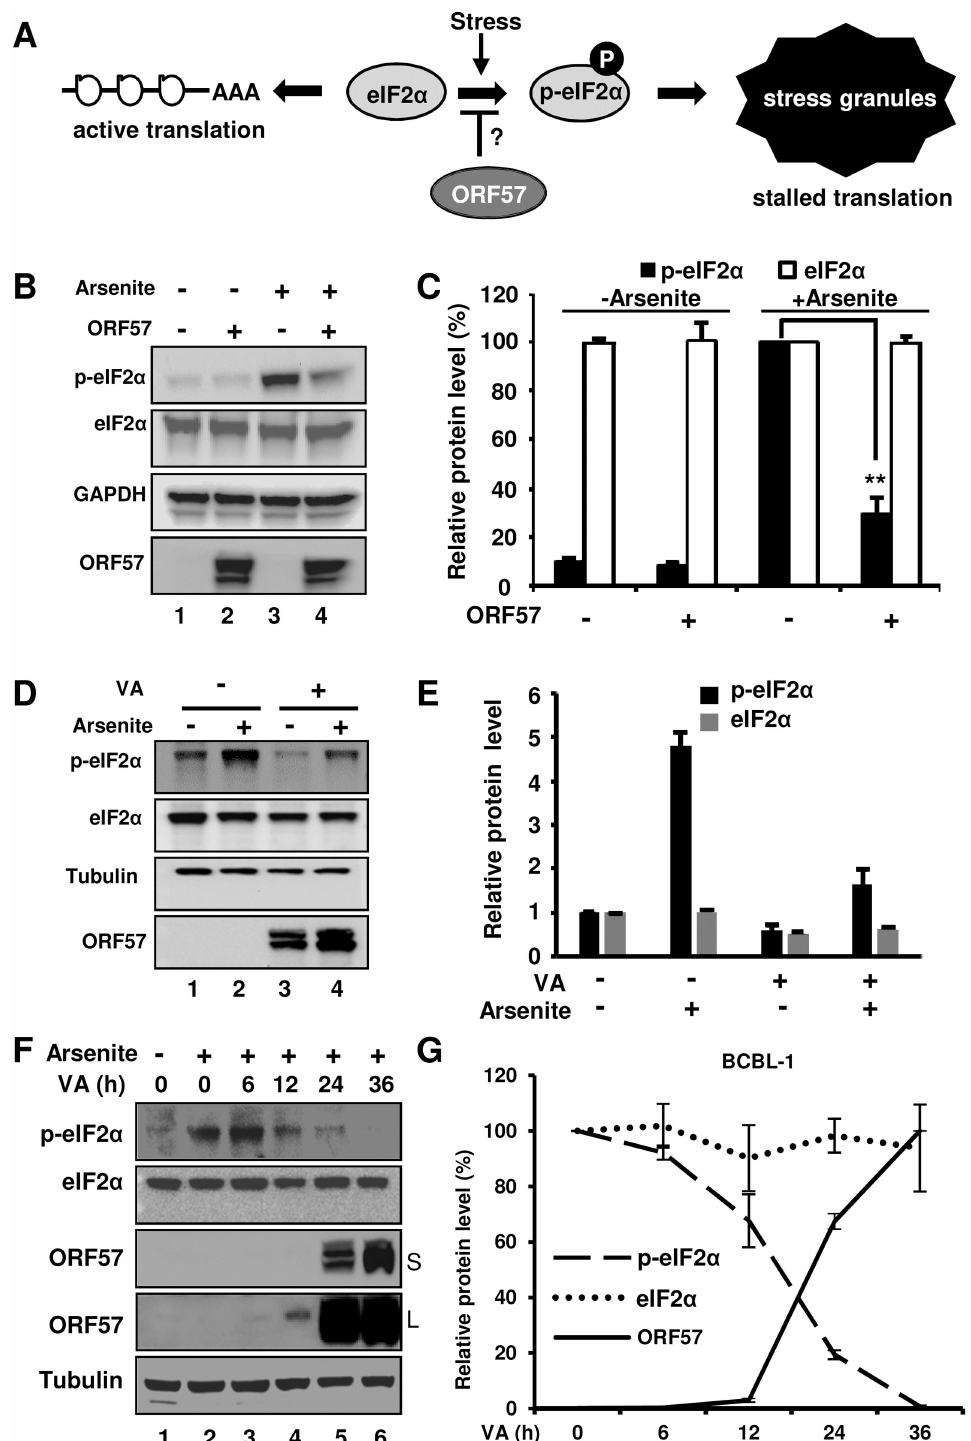
Fig 3. Viral ORF57 inhibits eIF2 α phosphorylation. (A) Schematic diagramsshowingthe governingprocess of SG formation and the possiblemechanismby which ORF57 may prevent it. (B) ORF57 inhibitseIF2 α phosphorylation. HeLa cells transfected with an empty (-) or ORF57 expressing(ORF57) vector were treated with arsenite. The phosphorylated eIF2 α (p-eIF2 α ) was measuredby Western blot analysisusing a Ser 51 phosphor-specific eIF2 α antibody. Total level of eIF2 α was determined by a pan-eIF2 α antibody.GAPDH served as a loadingcontrol. (C) Graphicalrepresentation of the relative amount of p-eIF2 α (black) and eIF2 α (white) in the panel B. The relative intensity of the protein band in each sample, after normalizingto GAPDH,